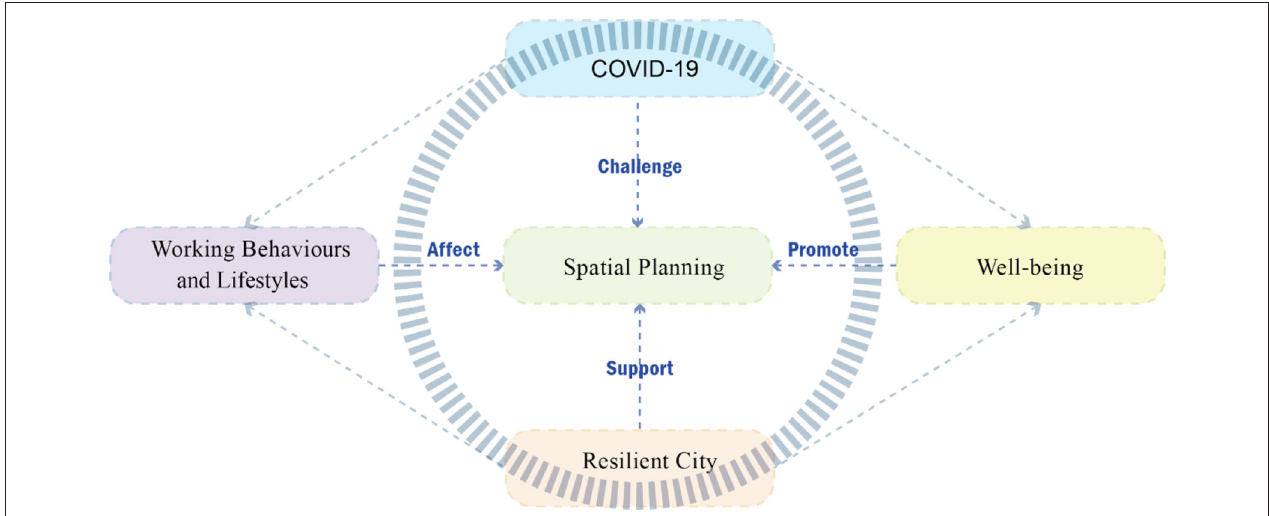
FIGURE 1 | Theoretical framework: how spatial planning plays a significant role in terms of behavioural change, well-being, and creating a resilient city in response to the effects of the COVID-19 pandemic (Source: Authors).